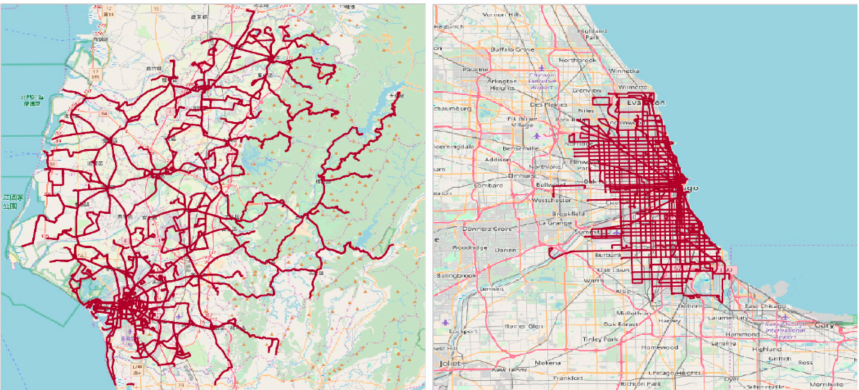
Figure 3. Public transit networks for Tainan ( left ) and Chicago ( right ) on the same scale.